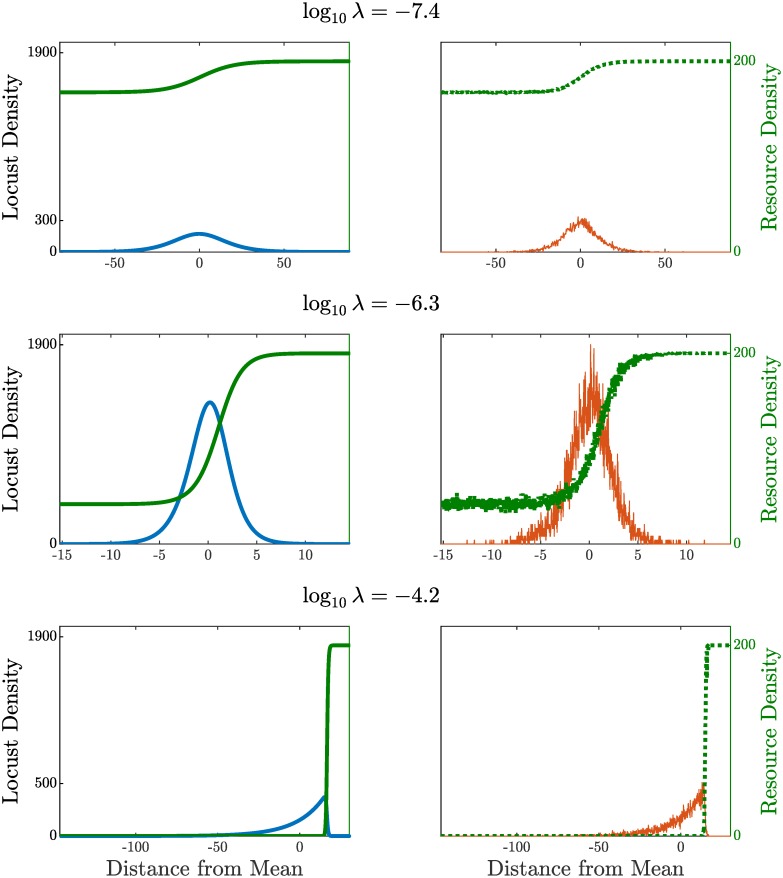
Model outputs from direct numerical simulation for 106 time steps.Density profiles from the PDE (blue, left) and histograms from the ABM (orange, right) for selected foraging rates log(λ) = −7.4, −6.3, −4.2. For quick visual shape comparison, all outputs shifted so that center of mass is x = 0. Each plot corresponds to a data point in Fig 7 (gold x for ABM, gold dot for PDE). Note the differences in scale on the horizontal axes in each plot.